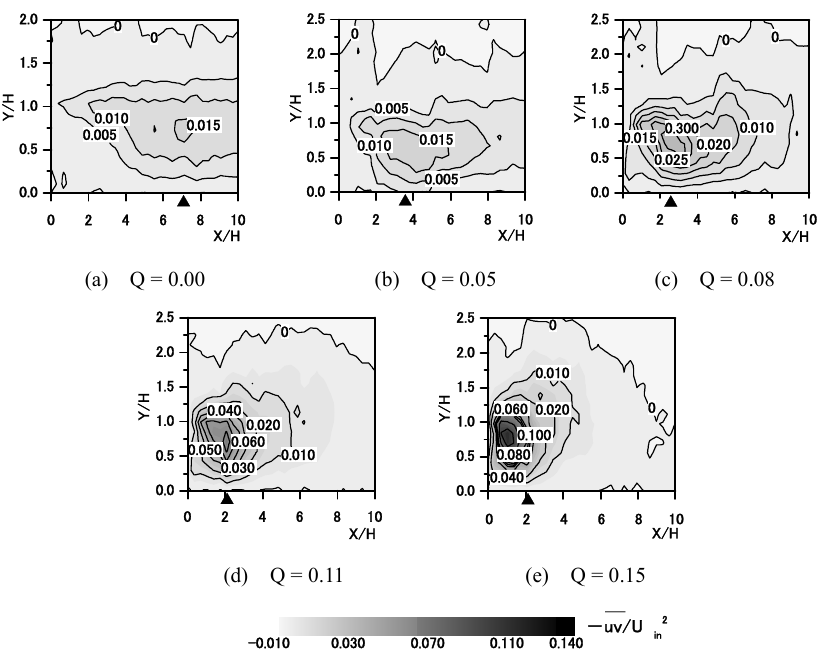
Fig. 14 Contours of Reynolds shear stress